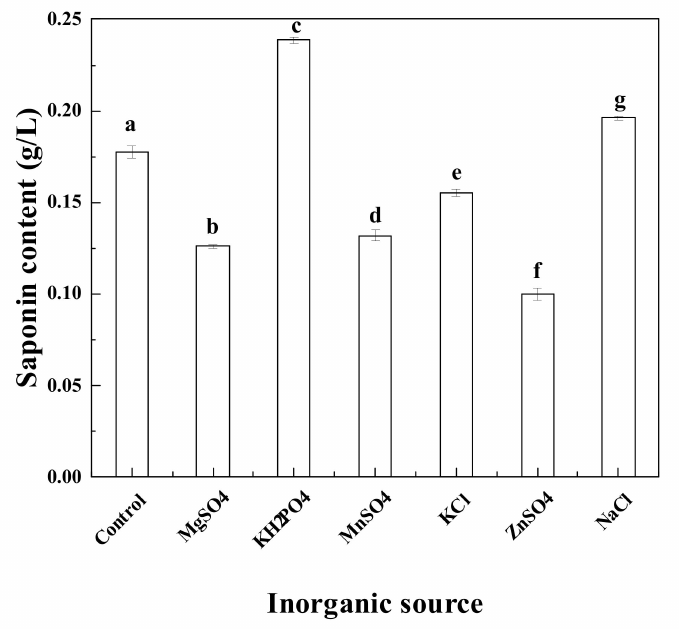
Figure 3. Effects of inorganic salts on the saponin production of T. melanosporum . (Different letters on the top of column indicate significant differences between means: a, b, c, d, e, f, g, p < 0.05).